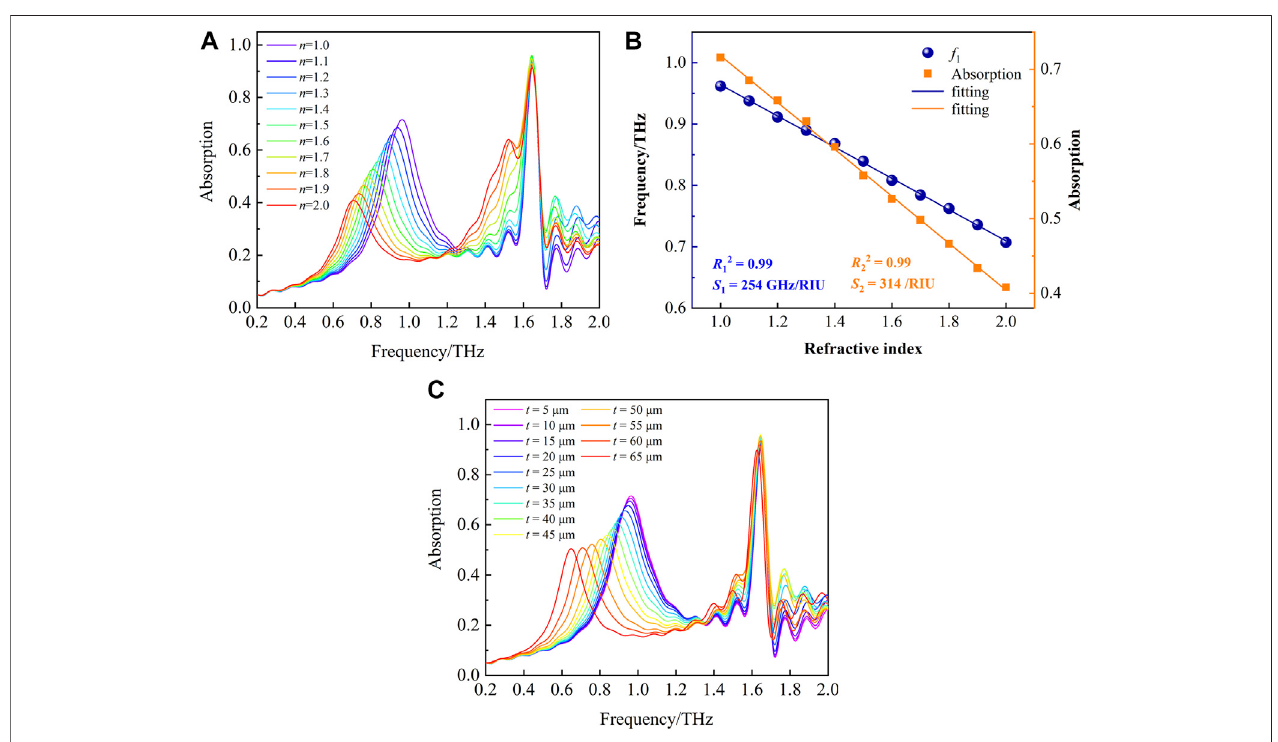
FIGURE 3 | (A) Absorption spectra for the analytes with different refractive indices. (B) Regression curves fi tted for the refractive indices increases from 1.0 to 2.0, where the fi lling thickness of the analytes t (cid:1) 45 µm. (C) Absorption spectra of the proposed composite metasurface with different fi lling thickness, where the refractive index of the analytes is n (cid:1)